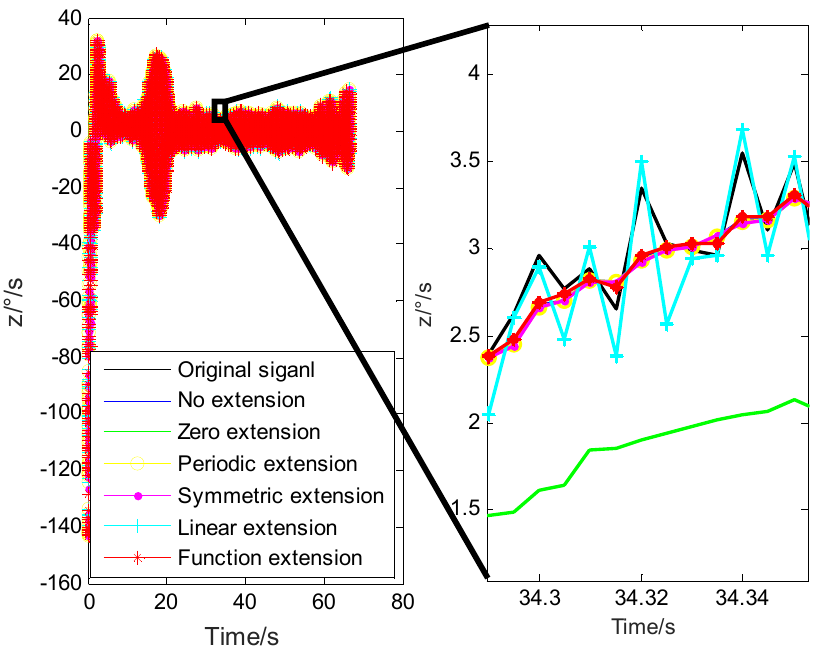
Figure 11. De-noising results of different extension methods for the actual data.